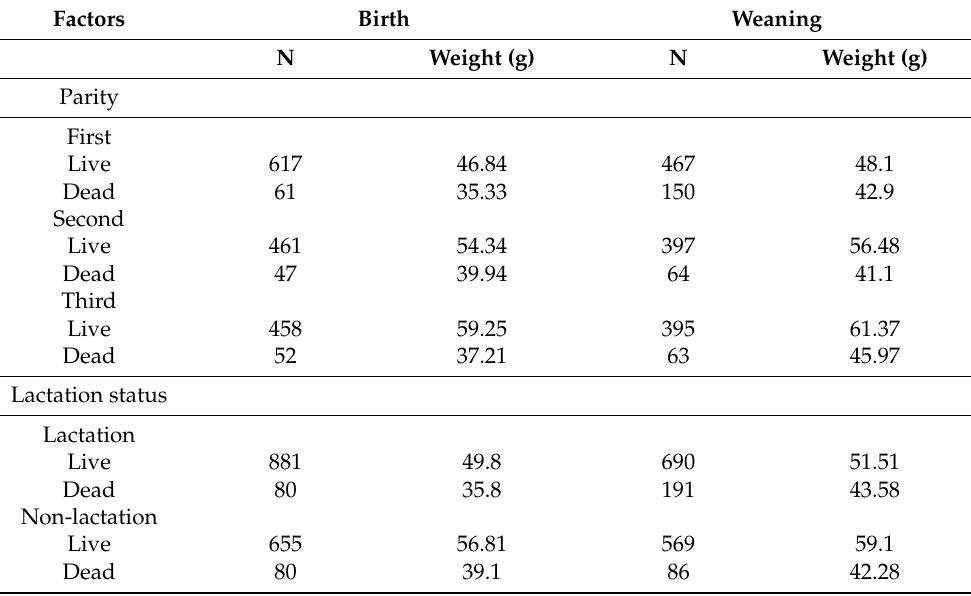
Table 3. Number of observations (N) and birth weight for kits alive and dead at birth and weaning.